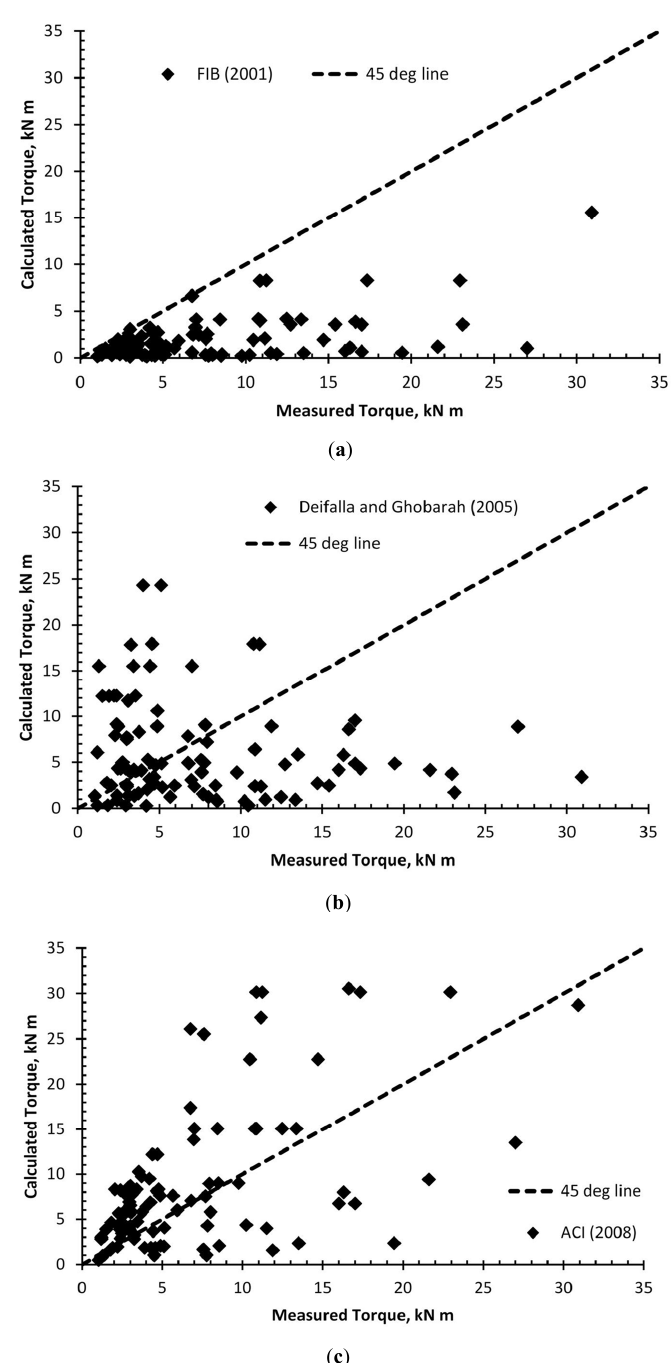
Figure 6. Calculated ultimate strength versus that measured using ( a ) Fib; ( b ) Deifalla and Ghobarah; ( c ) ACI.